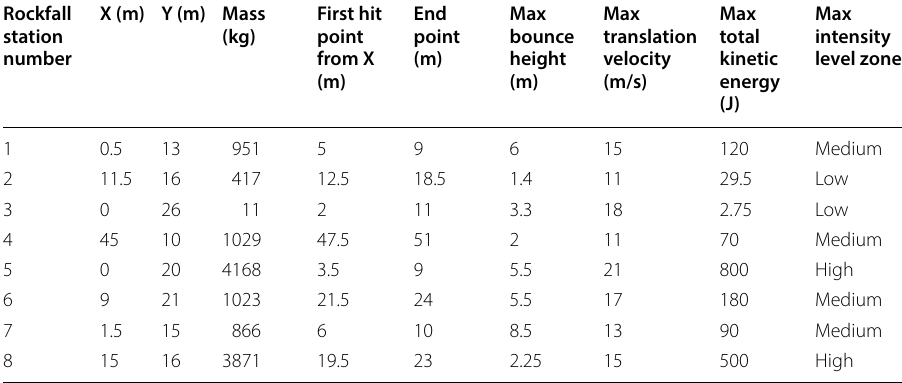
Table 4 Results of RocFall program simulation for eight site of NH-15 Rockfall